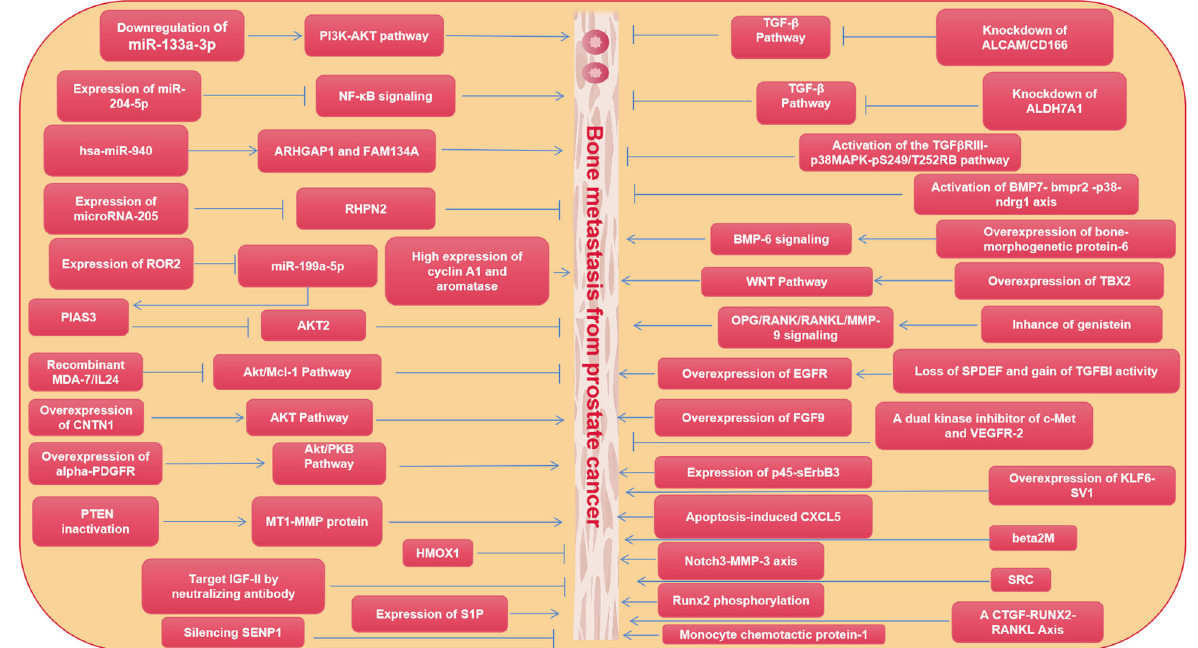
Fig. 2 Different factors that inhibit or promote bone metastasis from PC. In fl uence of different signaling pathways and drugs on bone metastasis from PC.